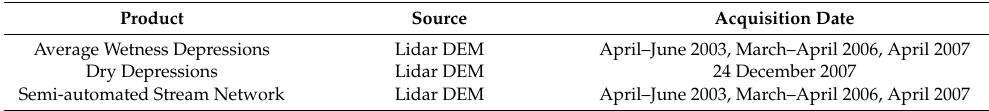
Table 1. Products used in the analysis, their sources and date of acquisition. Lidar: light detection and ranging. DEM: Digital elevation model. ETWI: enhanced topographic wetness